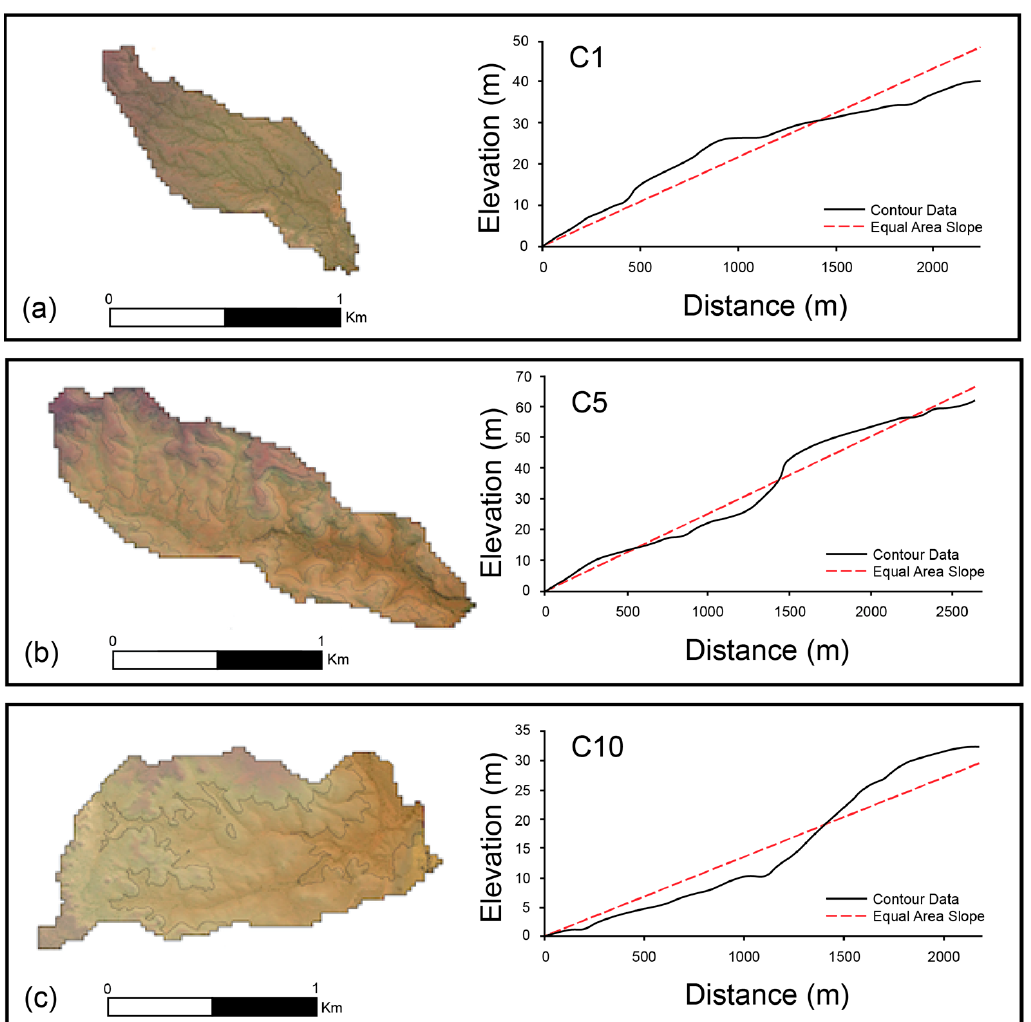
Figure 8. Catchments used in sensitivity analysis. ( a ) Catchment 1—A small shallow unconfined catchment with multiple flow paths, ( b ) Catchment 5—A steep, confined catchment and ( c ) Catchment 10—An unconfined single thread channel within a larger catchment. Graphs show the contour data of the longitudinal profile of the river channel. The red dashed line shows the equal area slope.